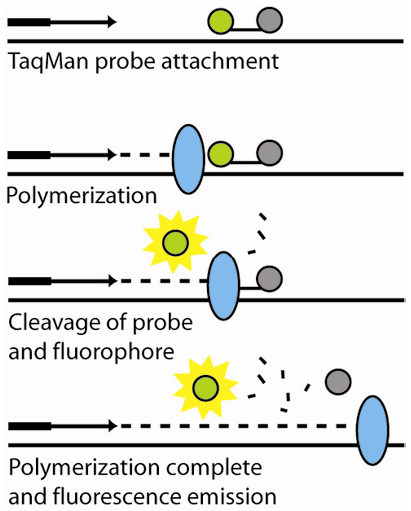
Figure 6. The TaqMan assay, also known as the 5’ nuclease assay utilizes a third oligonucleotide labeled with a fluorophore (green) and quencher (gray), in which the fluorophore is quenched due to FRET conditions. During the reaction, the DNA polymerase (blue) degrades the probe, separating the fluorophore and quencher, allowing for fluorescence emission to occur.